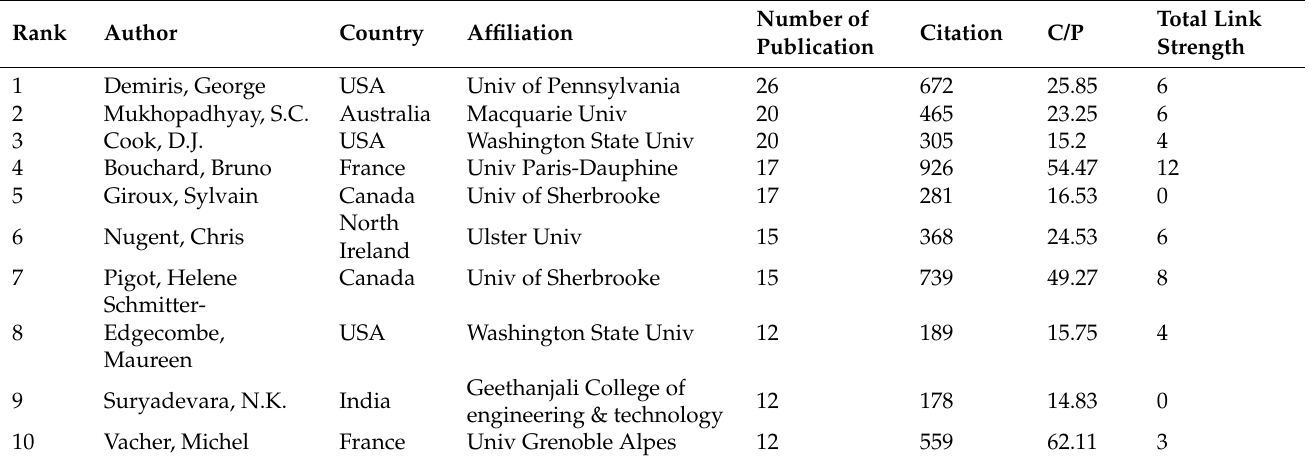
Table 6. Top 10 most productive